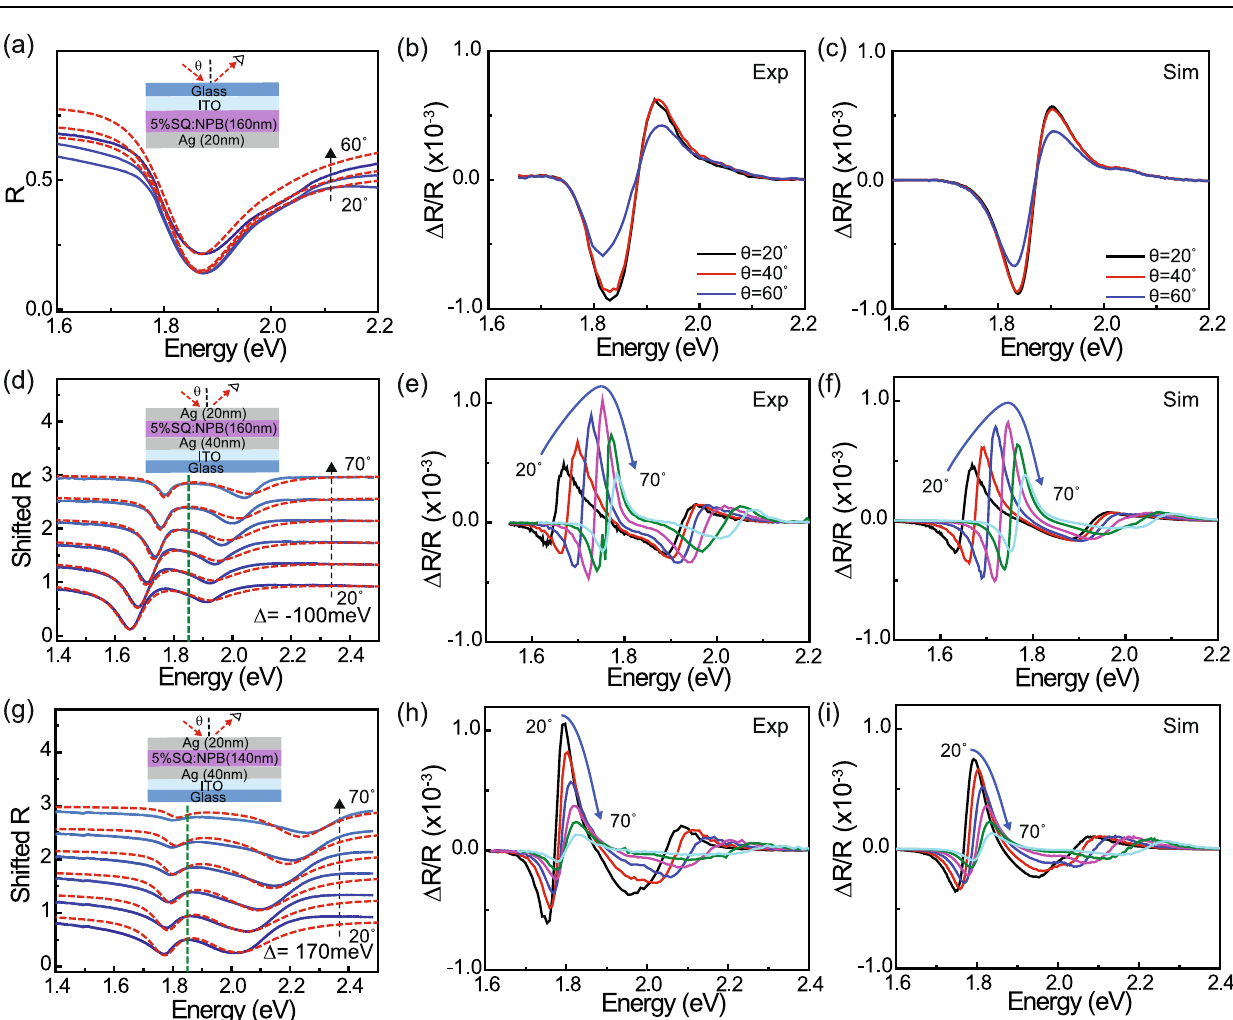
dispersion as described in the main text. d Measured (solid lines) and simulated (dashed lines) s-polarized re fl ectivity spectra for a negatively-detuned ( Δ = (cid:2) 100meV) 5wt% SQ:NPB microcavity in the strong coupling regime. The green dashed line indicates the energy of the bare exciton transition. Pan e ls e and f respectively show measured and simulated electrore fl ectance spectra for this cavityusingthesameelectric fi eld-perturbedopticalconstantdispersionasforthe half-cavity device in panel c . g – i Analogous results obtained for a positively- detuned ( Δ =170meV)